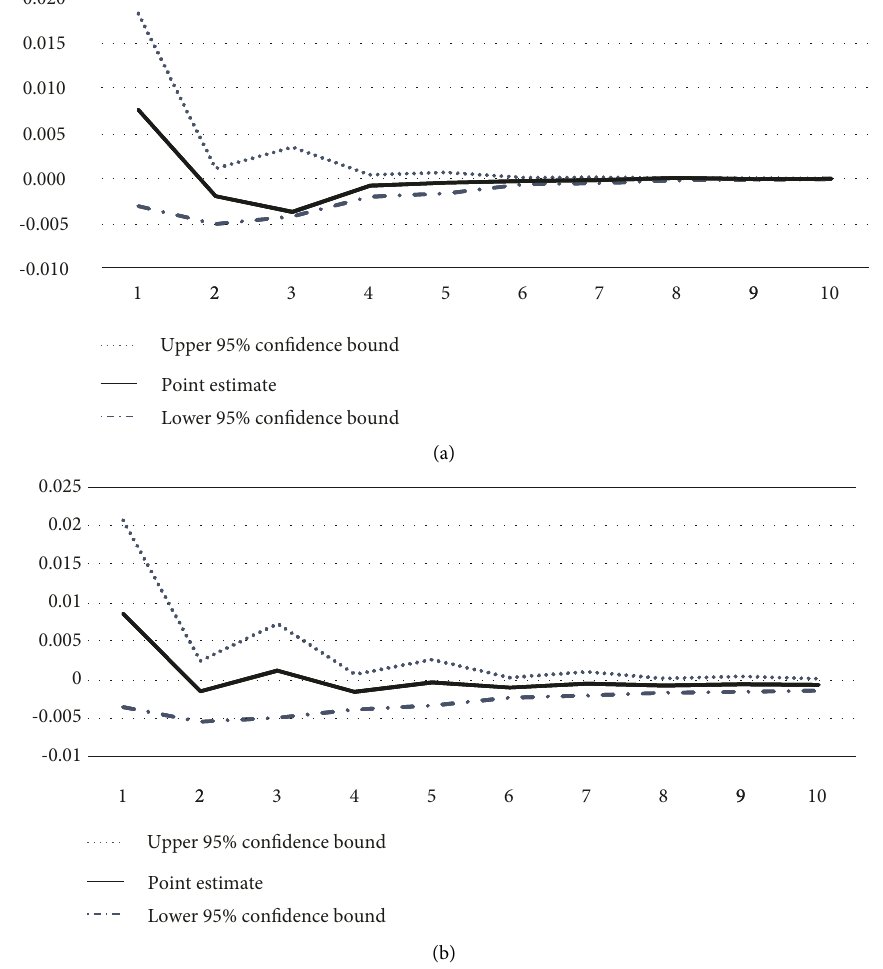
Figure 5: Impulse response estimates of profitability efficiency by the financial crises in 2001 (a) and 2009 (b) with 95% confidence